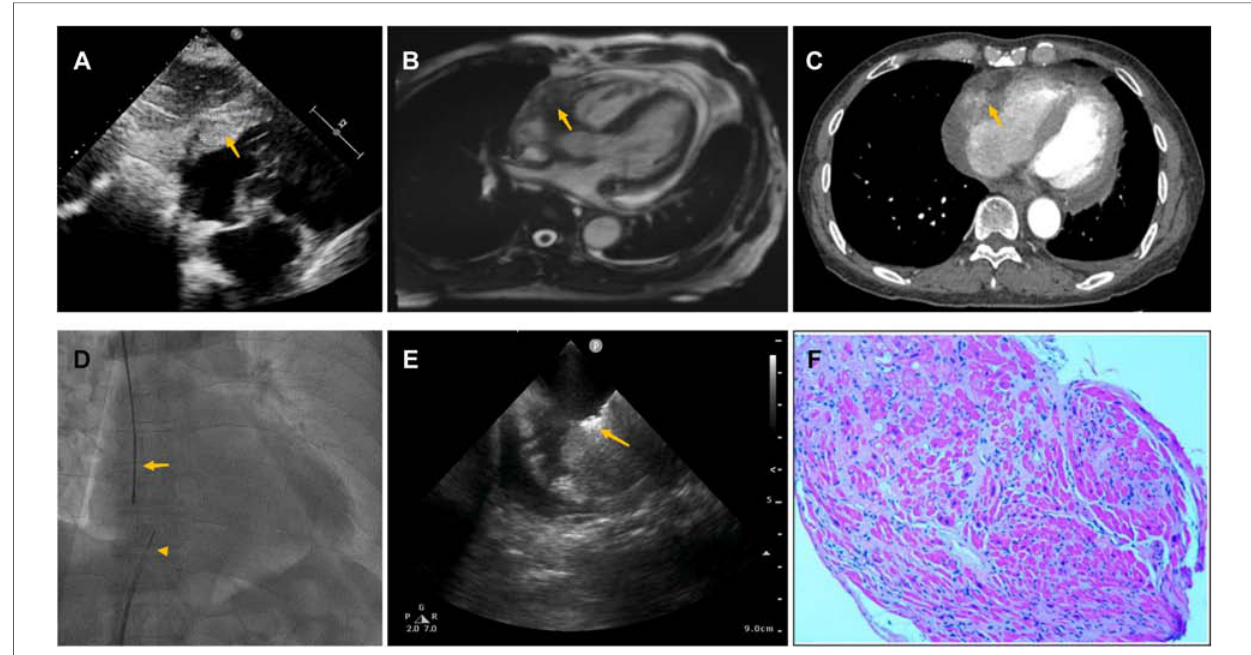
FIGURE 5 Multiple investigations for diagnosis of Case3. ( A ) Transthoracic echocardiography showed cardiac mass lesion (arrow) in the RA. ( B ) Chest enhanced CT, and ( C ) Cardiac enhanced-MRI revealed a large mass (arrow) at the junction of the RA and RV. ( D ) Catheter for intracardiac echocardiography (arrowhead) and cardiac bioptome (arrow). ( E ) The intracardial echocardiography demonstrates well-targeted biopsy catheter (arrow) on the mass. ( F ) Histopathological imaging revealed small vascular lumen formed by single cell, and cardiac epithelioid hemangioendothelioma (EHE) was